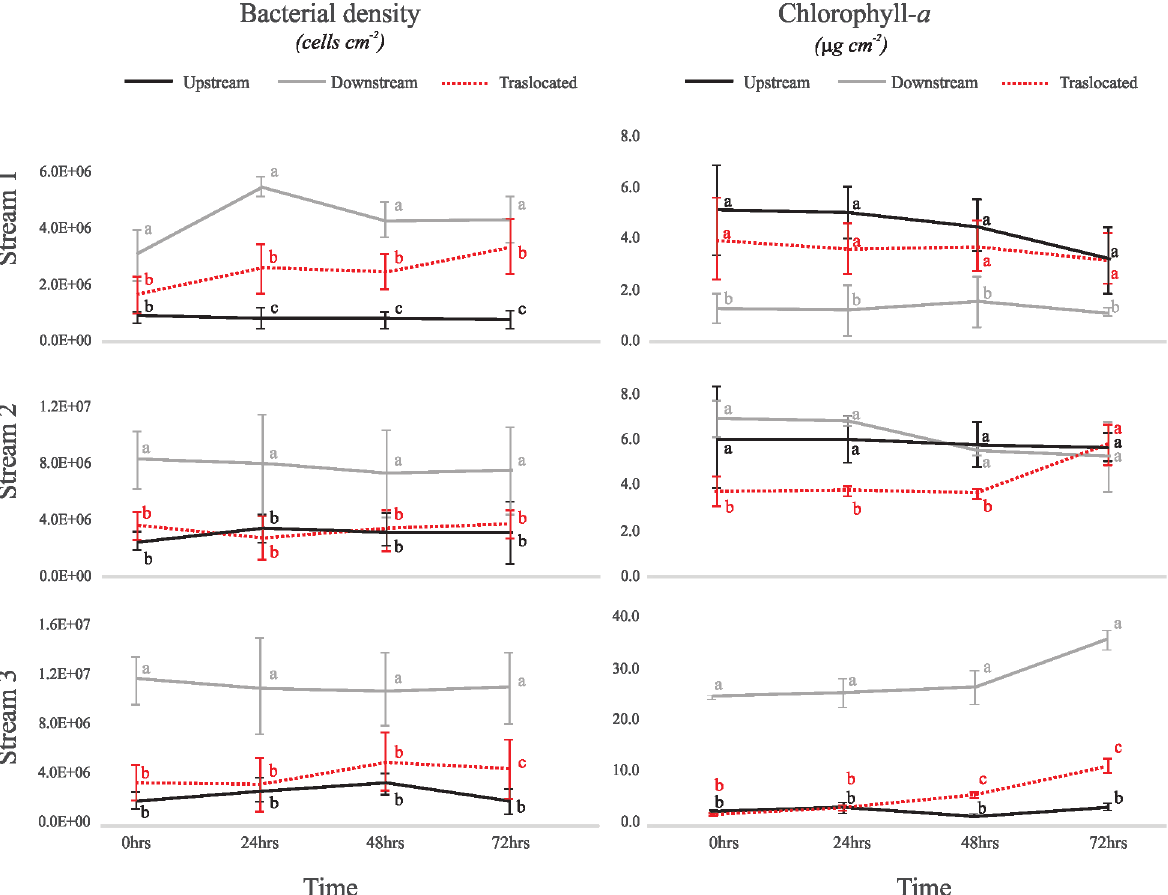
Figure 2. Mean (±SD) chlorophyll -a (µg cm -2 ) and bacterial density (cells cm -2 ) during the experiment in the Upstream (black solid line), Downstream (gray solid lines) and Translocated (red dotted line) treatments. Letters represent groups obtained from the post-hoc statistical analyses at each sampling time comparting between